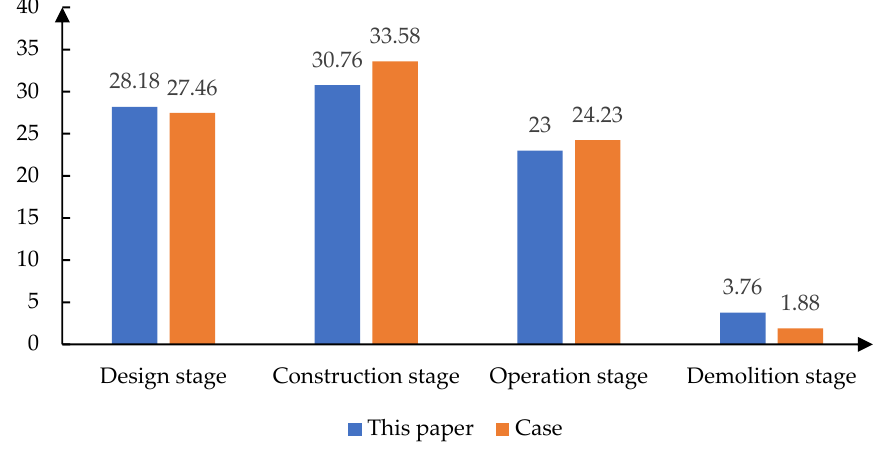
Figure 7. Comparison of benefit scores at various stages.